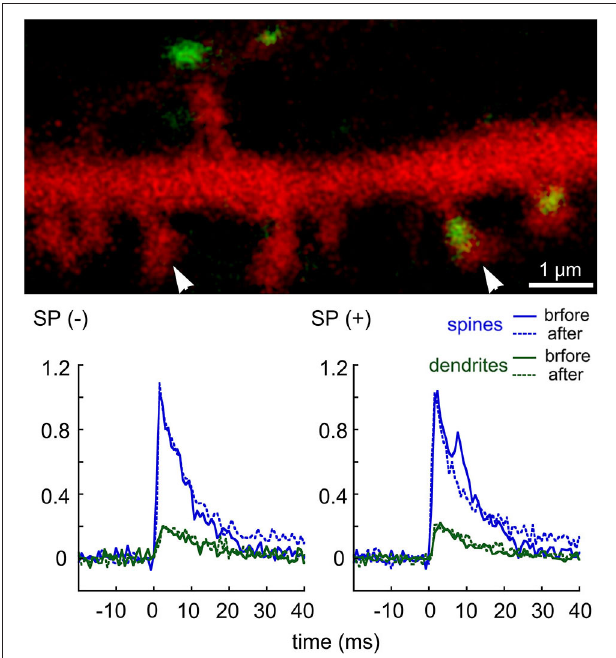
FIGURE 1 | Transient rise of [Ca 2 + ] i following flash photolysis of caged EGTA in dendritic spines of cultured hippocampal neurons . DsRed-transfected cells were loaded with a calcium indicator Fluo-4, and with the caged EGTA, the flash was focused on different dendritic spines in the field of view, and the transient elevation of [Ca 2 + ] I was recorded using line scan mode across the spine head and parent dendrite. The culture was then exposed to thapsigargin, and the same spines were imaged again. Following the experiment, cultures were fixed and immunostained for SP. Comparisons were made between SP-containing (right arrowhead) and SP-lacking spines (left arrowhead). For each sample ( n = 9 spines), the transient rise of [Ca 2 + ] i in both the spine head (blue) and parent dendrite (green) were plotted, before (continuous line) and after thapsigargin (dotted line). A secondary “hump” in the transient rise of [Ca 2 + ] i was seen only in the SP( + ) spines but not in the SP( − ) ones. This hump was erased in the presence of thapsigargin (after). Scale in image, 1 µ m, ordinate is the averaged transients (df/f). (modified from Korkotian and Segal,